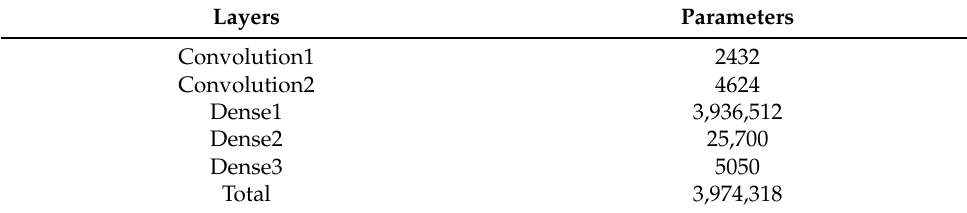
Table 4. The number of parameters for different layers of the